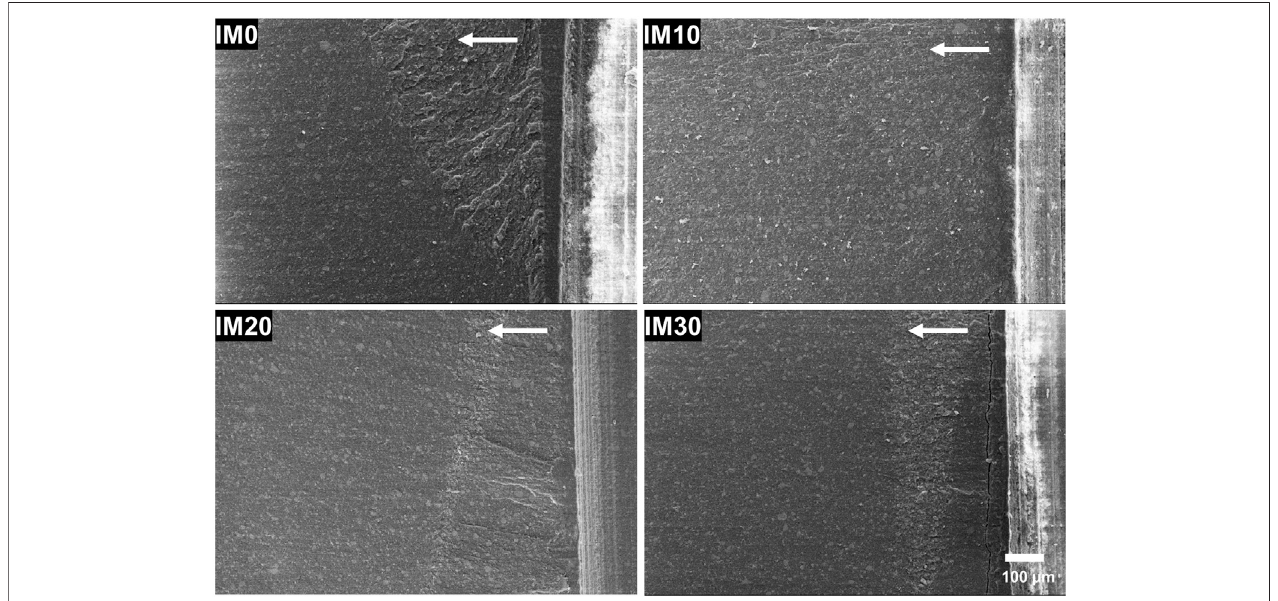
FIGURE 8 | Data from dynamic mechanical analysis of the 3D printed nanocomposites. (A) storage modulus (E ′ ), and (B) damping coef fi cient (tan δ ) asfunctionsoftemperature. TheT g valuesweredeterminedfromthepeaksof the tan δ vs temperature plots. The dotted blue line belongs to SP10, an AESO/PEGDA/nHA based nanocomposite from our previous work (Mondal et al., 2021), analogous to IM0.